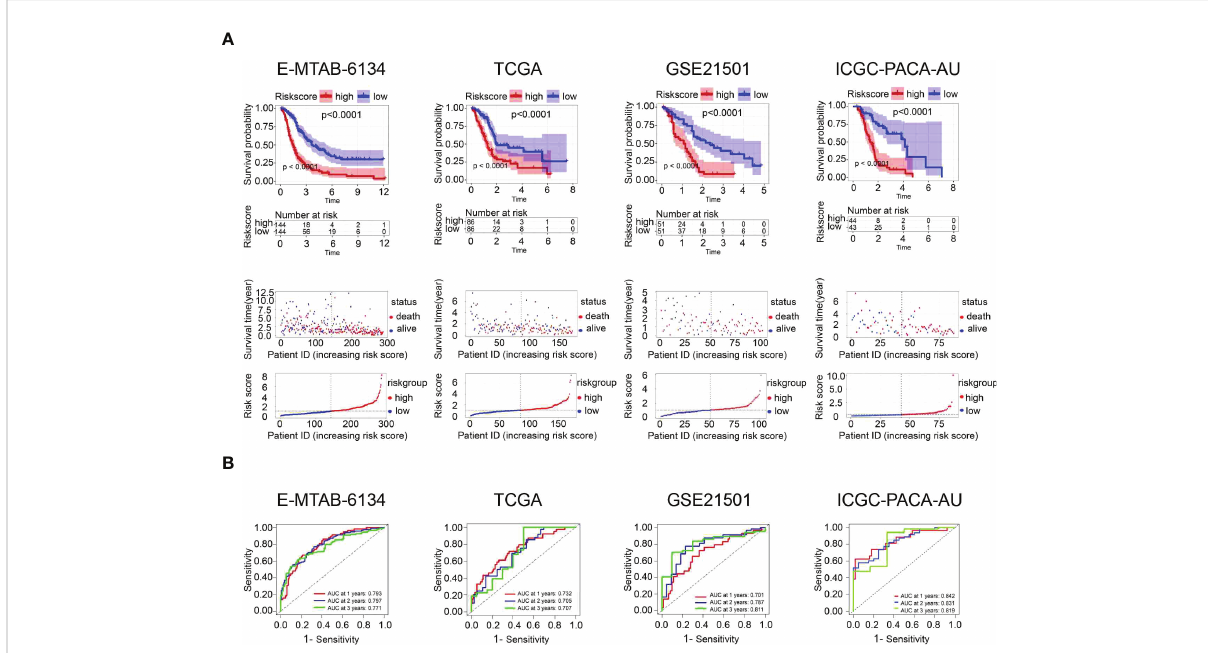
FIGURE 4 Prognostic performance of the UPR-related signature in the training dataset (E-MTAB-6134) and three validation datasets (TCGA, GSE21501, ICGC-PACA-AU). (A) Kaplan ‒ Meier survival curves, risk score distribution and survival status of patients in the high- and low-risk groups. (B) ROC curves were used to assess the predictive performance of the 1-, 2-, and 3-year